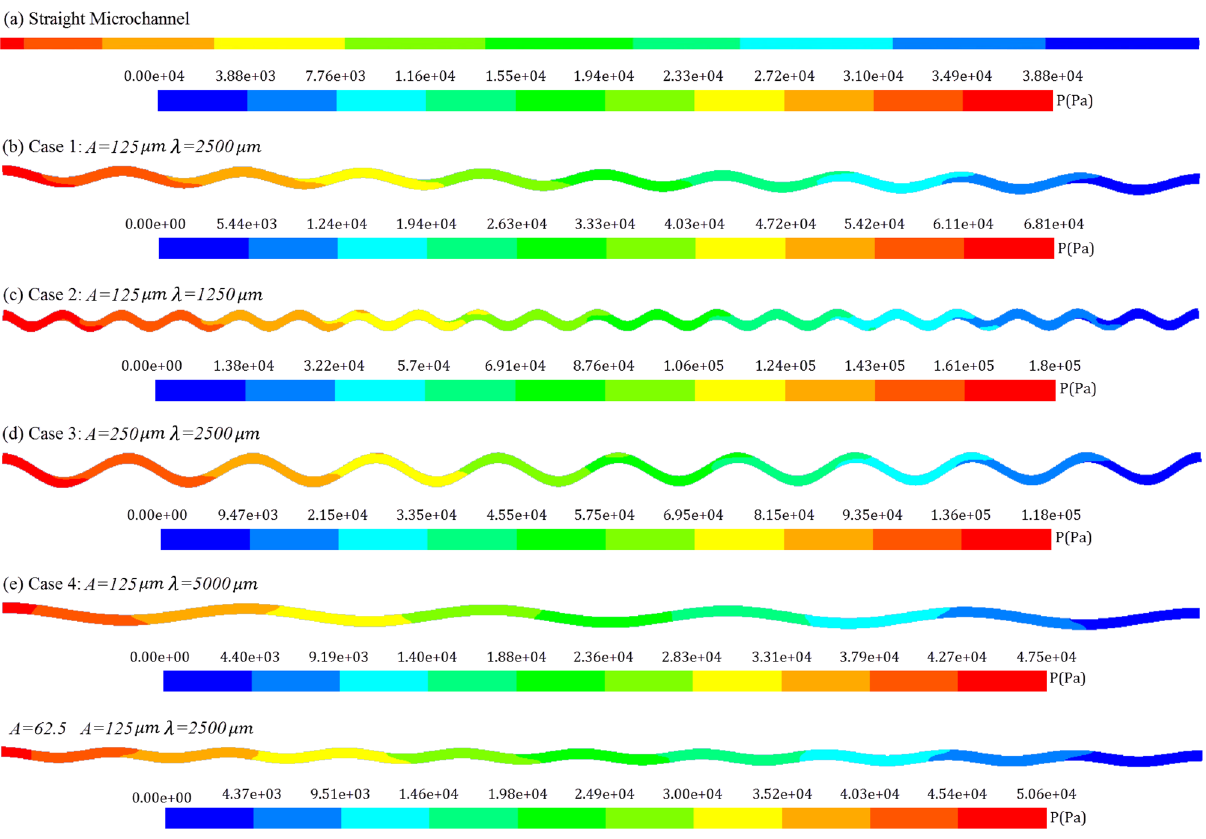
Figure 9. Pressure contours along the microchannel length for: ( a ) Straight channel, ( b ) Case 1 (A = 125 μm, λ = 2500 μm), ( c ) Case 2 (A = 125 μm, λ = 1250 μm), ( d ) Case 3 (A = 250 μm, λ = 2500 μm), ( e ) Case 4 (A = 125 μm, λ = 5000 μm), and ( f ) Case 5 (A = 62.5 μm, λ = 2500